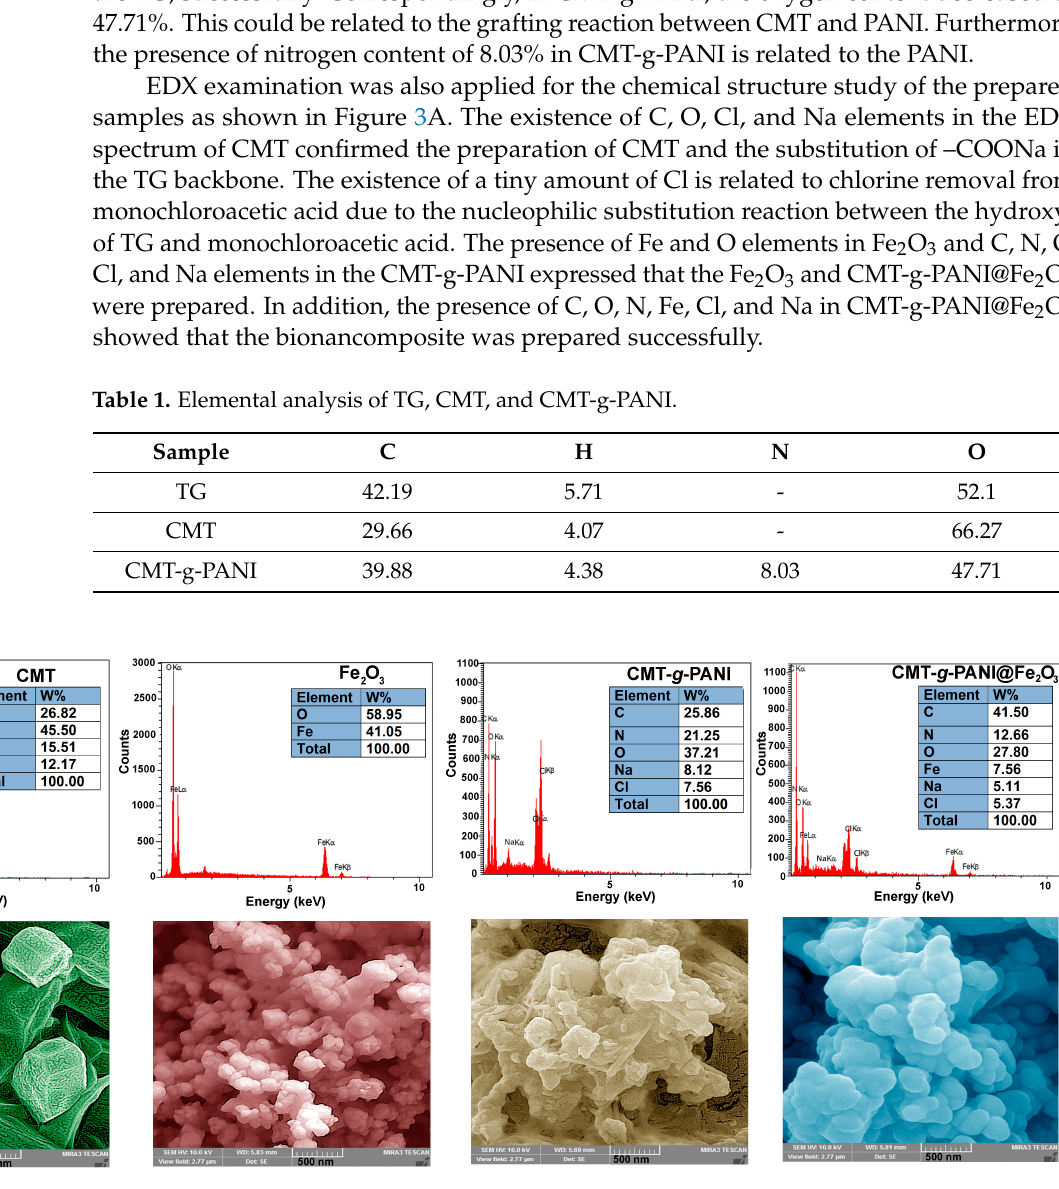
Figure 3. EDX spectra ( A ) and FESEM micrographs ( B ) of CMT, Fe 2 O 3 , CMT-g-PANI, and CMT-g- PANI@Fe 2 O 3 .